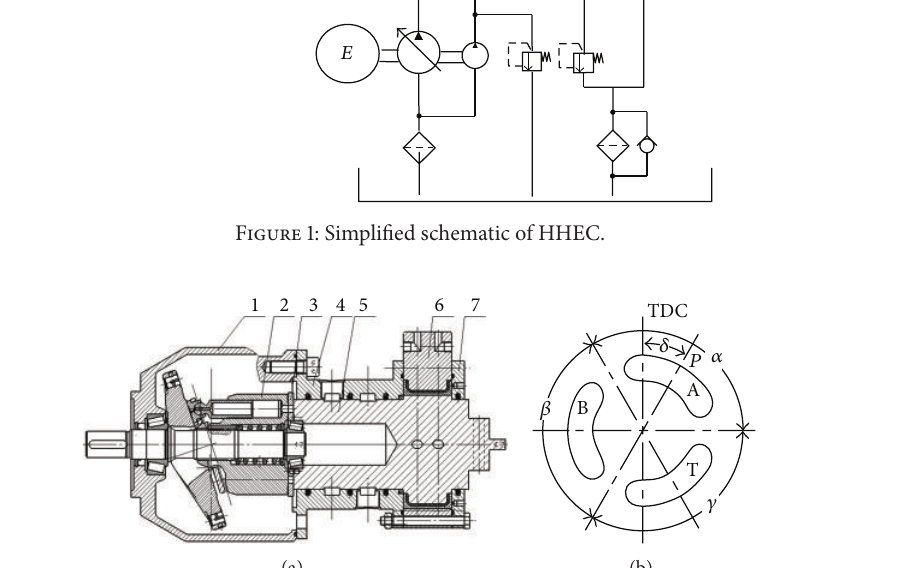
Figure 2: Structure of SHT. (1) Case of original pump. (2) Block of original pump. (3) New port plate. (4) Case of swing motor. (5) Rotor of swing motor. (6) Stator of swing motor. (7) Rear cover of swing